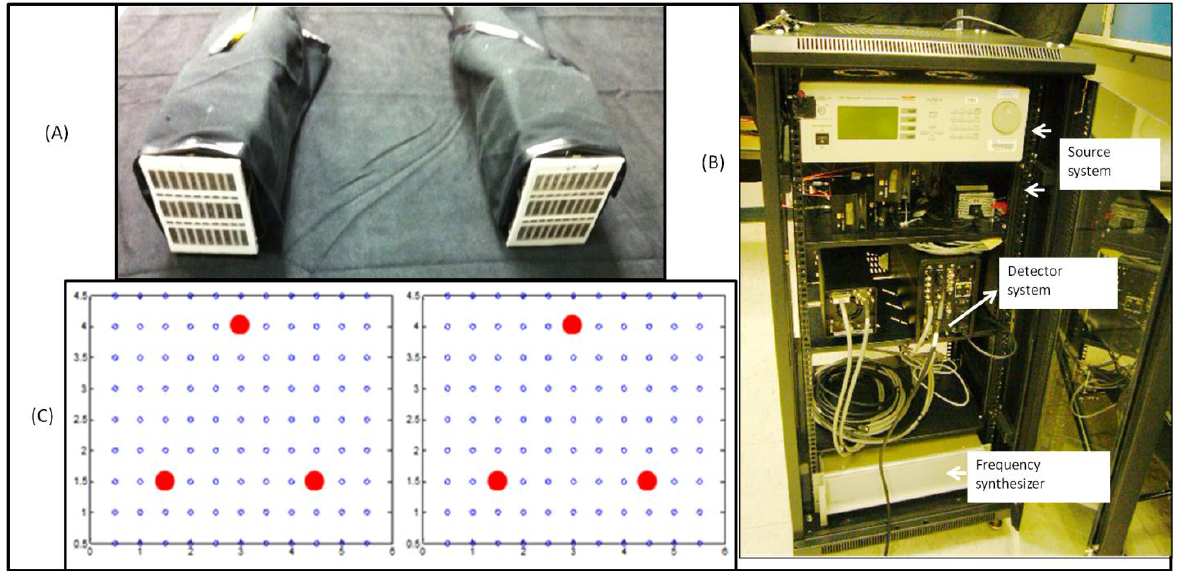
Figure 1. The hand-held optical imager set-up with ( A ) a forked hand-held probe, ( B ) a portable cart containing the source (laser diodes), detector (ICCD camera) and other components, and ( C ) source-detector layout for both probe heads. The red dots represent (sequential or simultaneous) illumination points and the black open circles represent detection